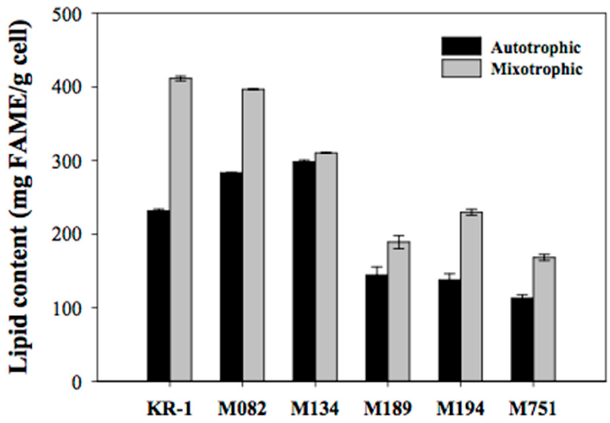
Figure 2. Lipid contents of six fast-growing Chlorella strains under autotrophic and mixotrophic conditions. The lipid contents of the cultures were estimated by FAME analysis after 96 h cultivation. The mixotrophic cultures were supplemented with 5 g glucose/L.